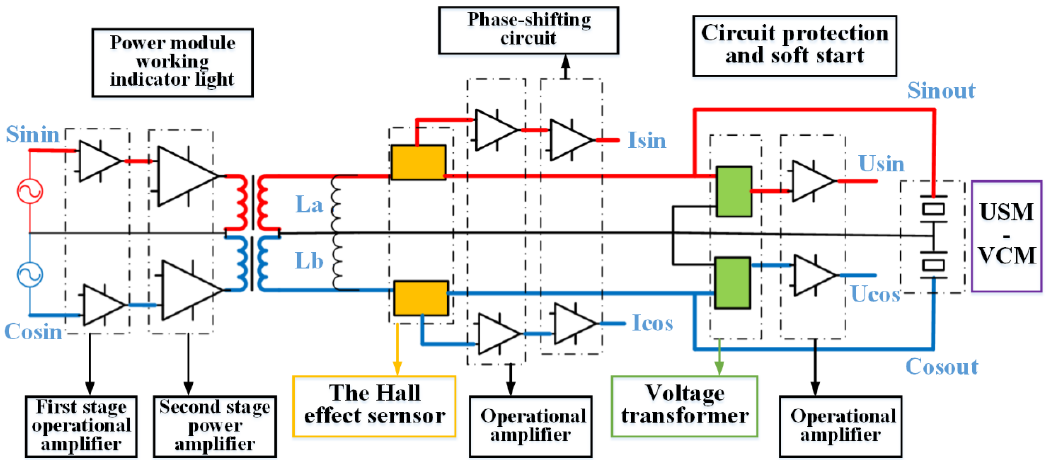
Figure 3. The structure of the USM and VCM mechatronic drive acquisition circuit.